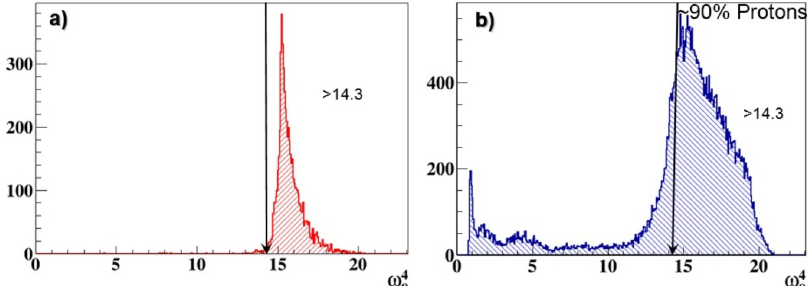
Figure 3. [Color online] Distribution of ω k n values for a) signal and b) background events